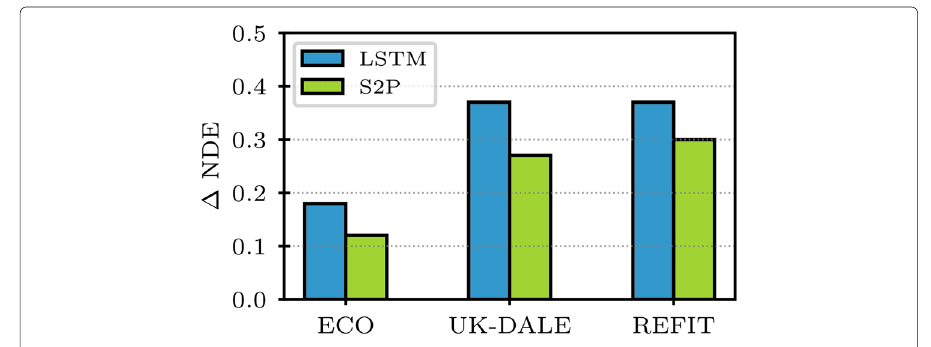
Fig. 8 Performance gap with regard to NDE for dishwashers